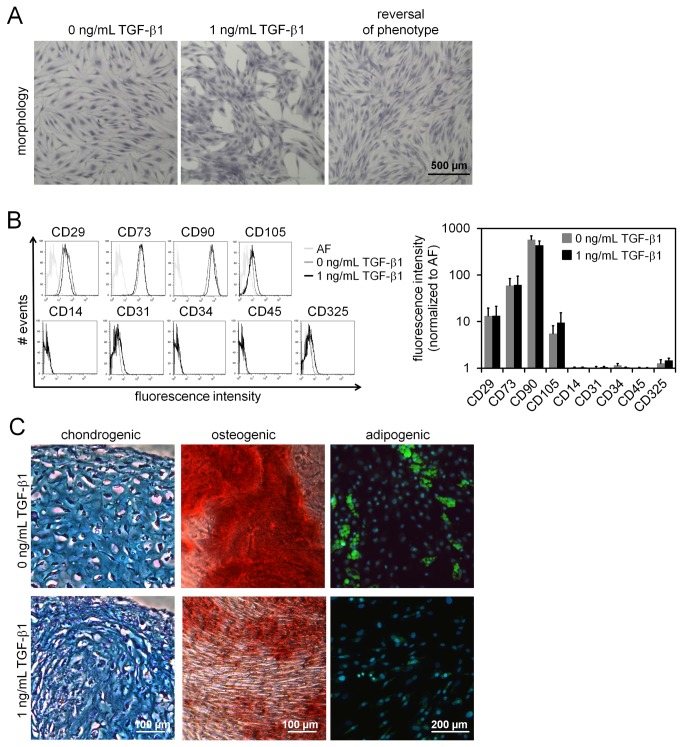
Influence of TGF-β1 on MSC growth and in
vitro differentiation.Treatment with 1 ng/mL TGF-β1 induces a network-like growth pattern of MSCs within 7 days, which is reversed if the cells are re-seeded in media without TGF-β1 (A; crystal violet staining of fixed cells). Immunophenotypic analysis of MSCs upon continuous culture either with or without TGF-β1 for 4 to 5 passages was performed by flow cytometry. Exemplary histograms are depicted and analysis of mean fluorescence intensity (normalized to auto-fluorescence) did not reveal significant differences upon treatment with TGF-β1 (B; n = 5). MSCs that had been cultured with or without 1 ng/mL TGF-β1 for 1 to 4 passages were differentiated towards chondrogenic, osteogenic and adipogenic lineage. Particularly adipogenic differentiation was impaired by TGF−β1 (C; n = 3).